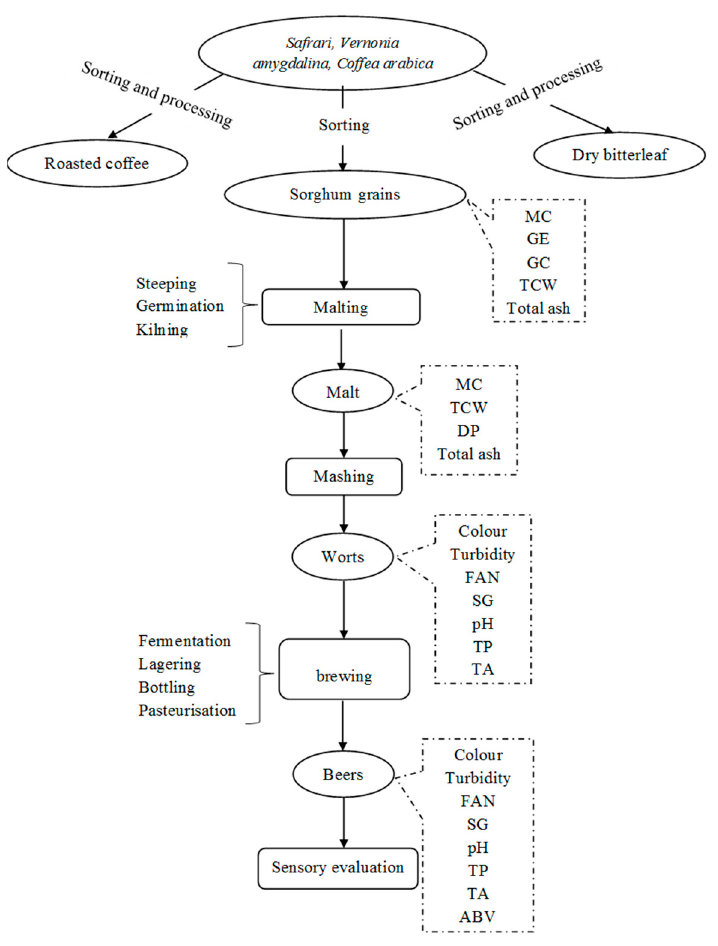
Figure 4. General work overview (MC = moisture content; GE = germinative energy; GC = germinative capacity; TCW = thousand corn weight; DP = diastatic power; FAN = free amino nitrogen: SG = specific gravity; TP = total polyphenols; TA = titratable acidity; ABV = alcohol by volume).